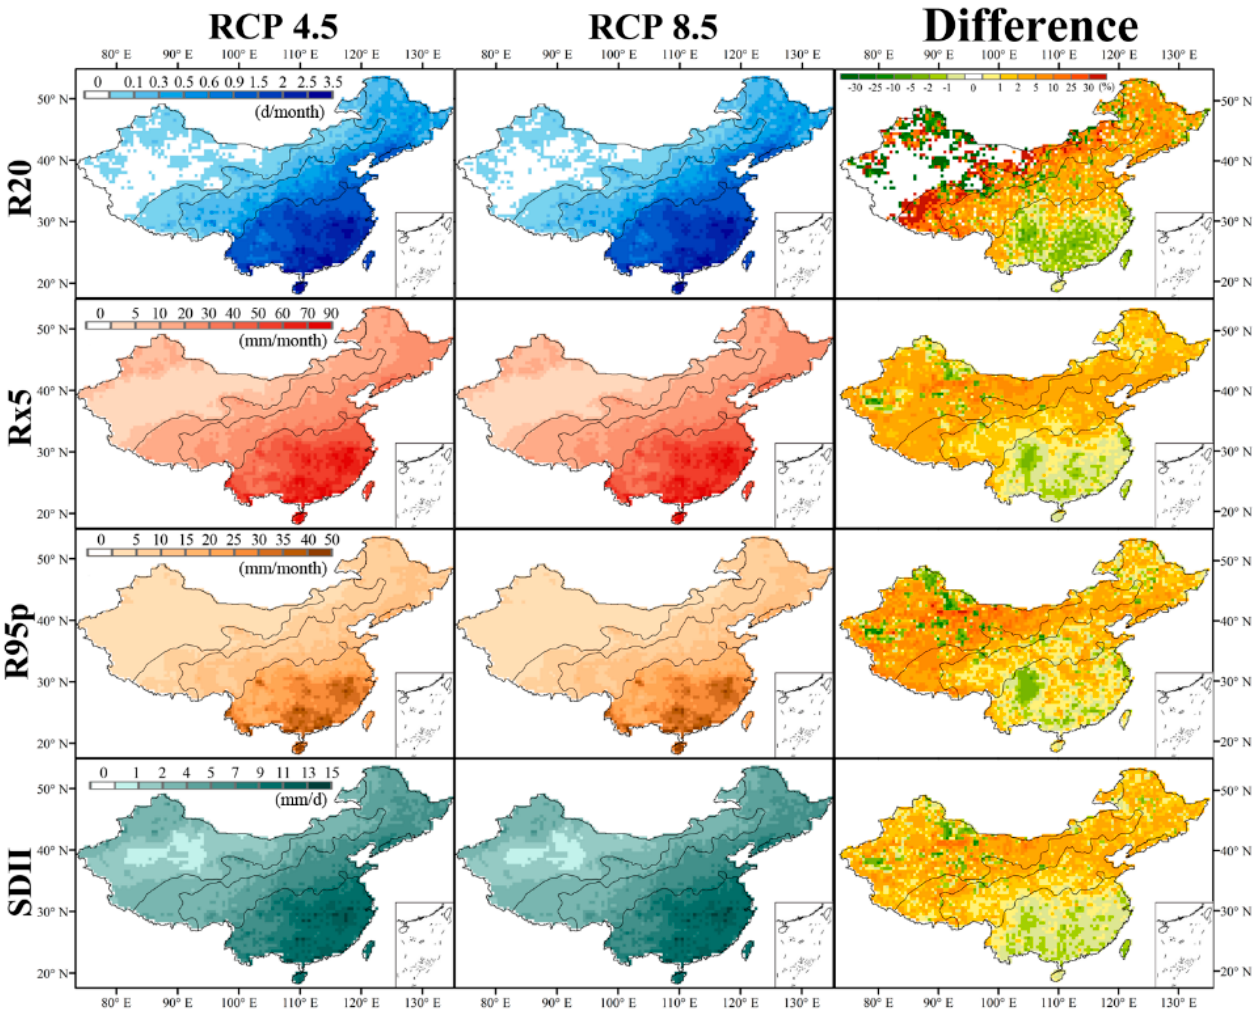
Figure 8. Spatial distribution of multi-year mean monthly precipitation indices and percentage differences between RCP4.5 and RCP8.5 scenarios in 2006–2099. (The calculation formula of percentage difference is (P RCP8.5 − P RCP4.5 )/P RCP4.5 × 100%, where P RCP4.5 and P RCP8.5 are precipitation index values under RCP4.5 and RCP8.5 scenarios, respectively.).